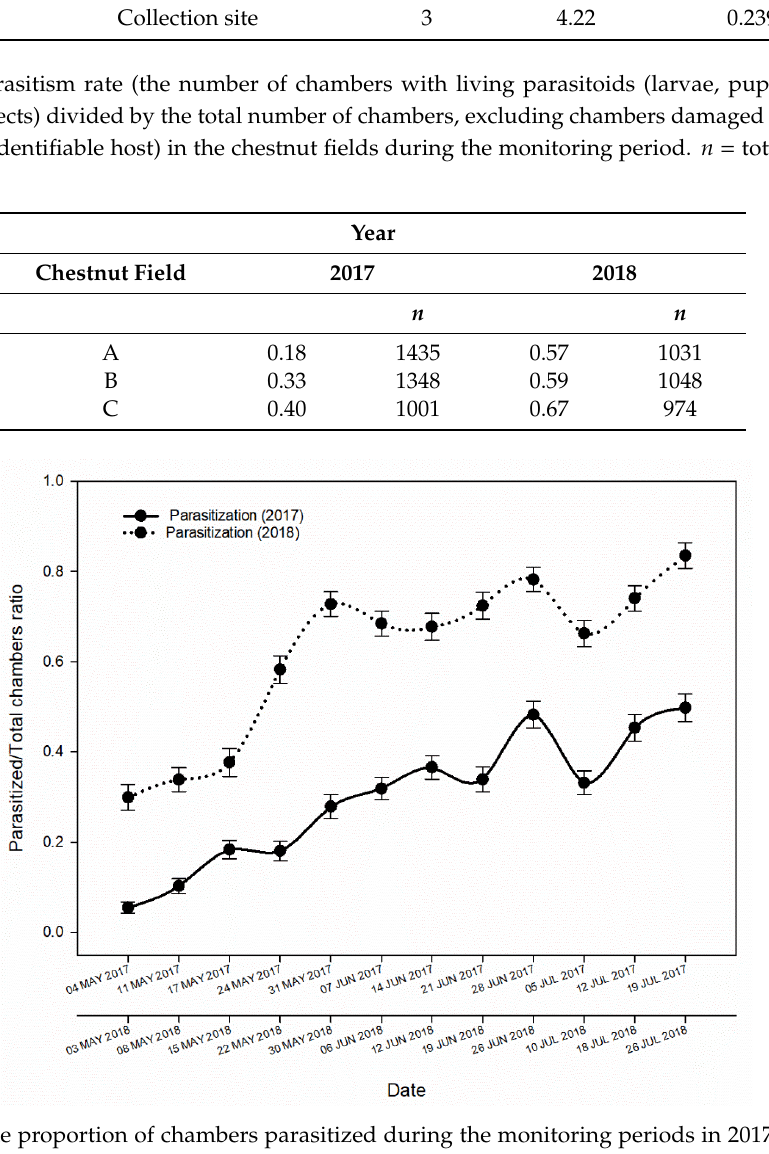
Figure 1. The proportion of chambers parasitized during the monitoring periods in 2017 and 2018. The data collected each year in the three chestnut fields were pooled. Table 2. The binomial generalized linear model (GLM)’s evaluation of the effects of different variables on the parasitism rate (2017: n = 3784; 2018: n = 3053).